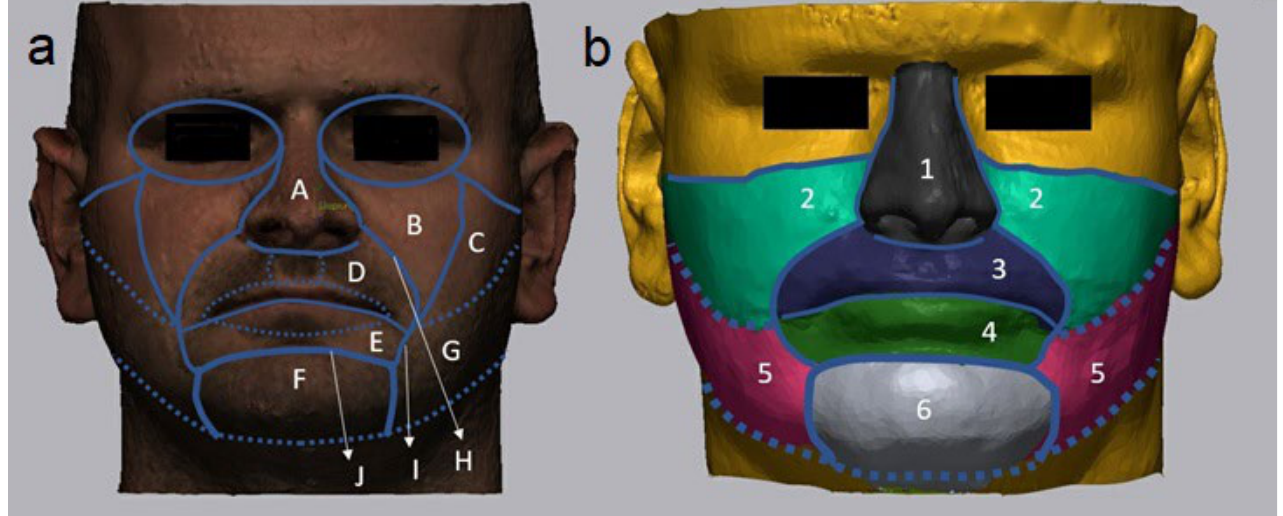
Figure 2. ( a ): Facial aesthetic units based on Fattahi et al. A: nose; B: cheek unit (medial subunit); C: cheek unit (zygomatic subunit); D: upper lip unit (philtrum + lateral + mucosal subunit); E: lower lip unit (central + mucosal subunit); F: mental unit; G: cheek unit (lateral + buccal subunit); H: melolabial fold; I: labiomandibular fold; J: mentolabial fold. ( b ): Segmentation of the soft-tissue simulation. 1: nose; 2: upper cheek (B+C); 3: upper lip (D); 4: lower lip (E); 5: lower cheek (G); 6: chin (F); 3+4: both lips; 1+2+3+4+5+6: face total. Table 2. Influence of the parameters (angle class, displacement distance, bite situation, age, and gender) on the IO%> Statistical significance was considered at p <